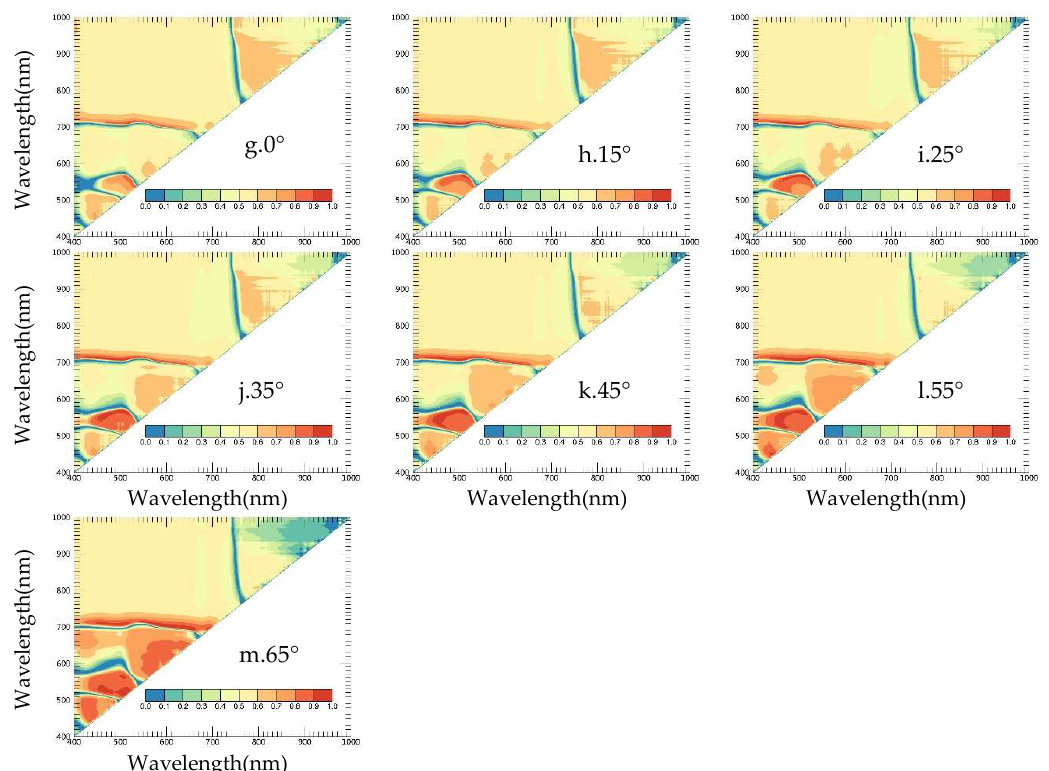
Figure 6. Contour maps of R 2 between NDSI(x,y) and the ground measured LAI for thirteen VZAs in PP for the erectophile variety based on in-situ measurements. Subtitle a.-m. shown in each graph denotes observation angle.